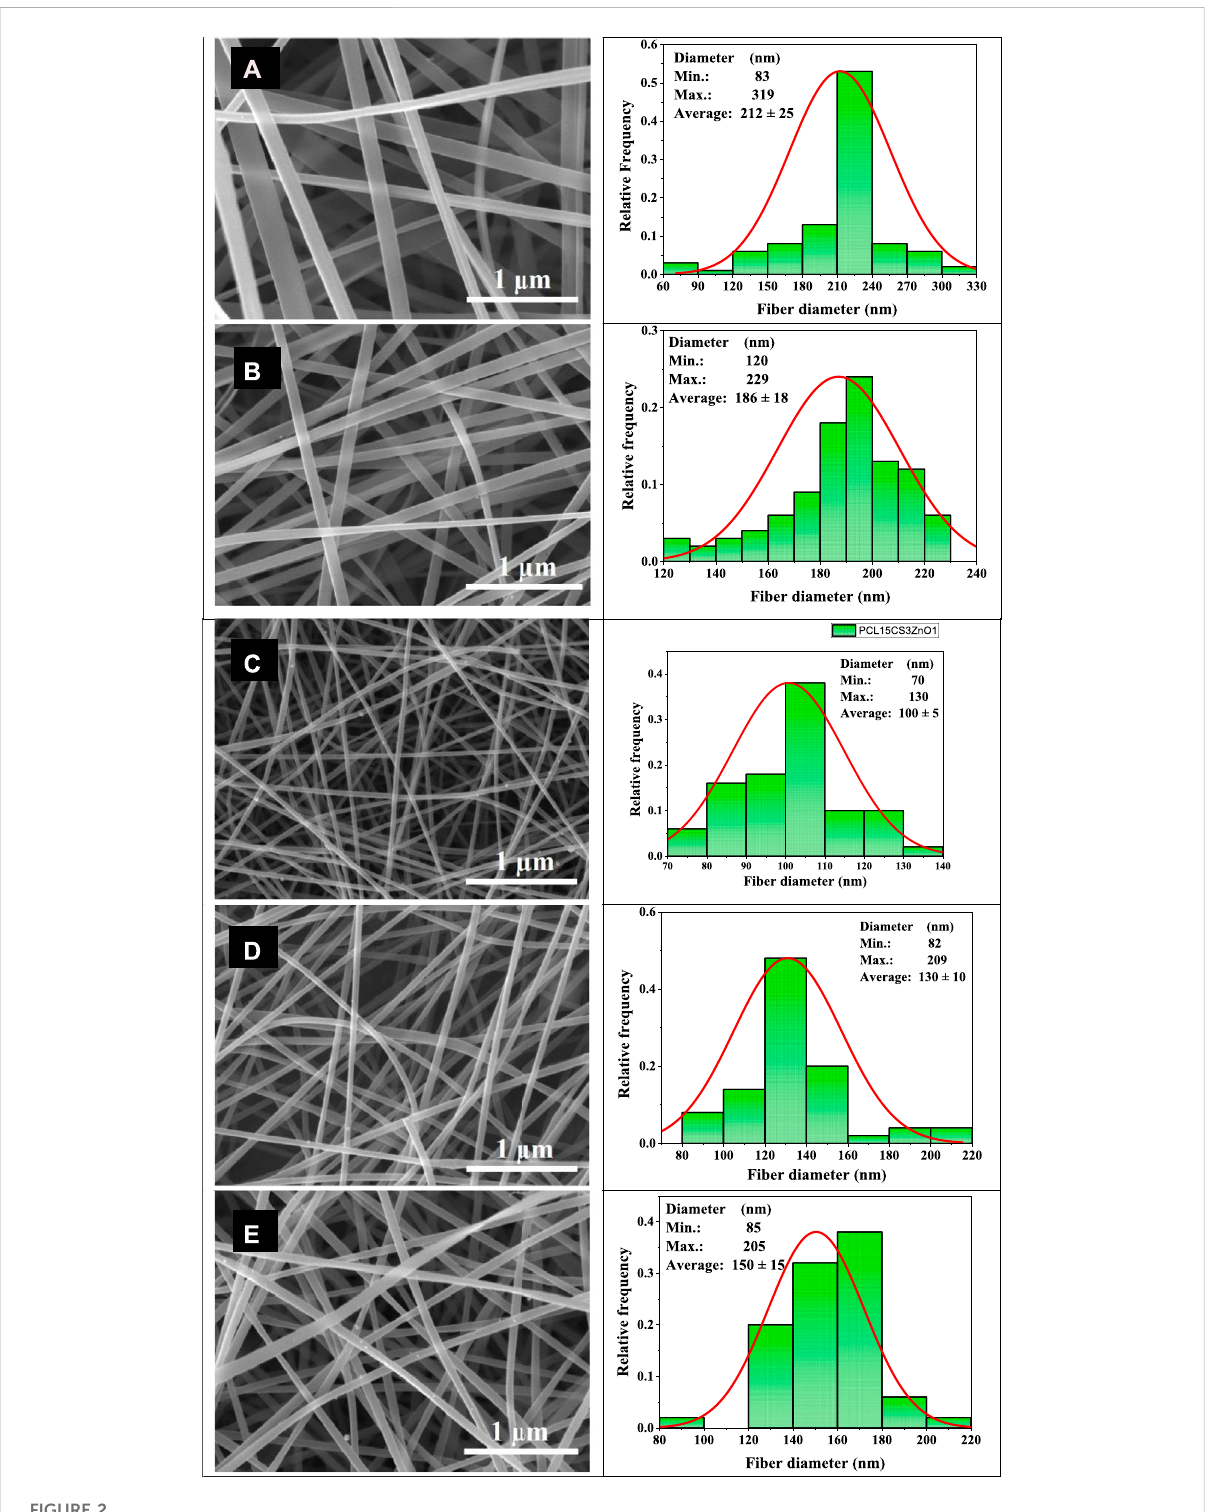
FIGURE 2 SEM images of the electrospun nano fi bers and their diameter distribution histograms, (A) PCL15, (B) PCL15CS3, (C) PCL15CS3ZnO1, (D) PCL15CS3ZnO1Cur1, and (E) PCL15CS3ZnO1Cur3.